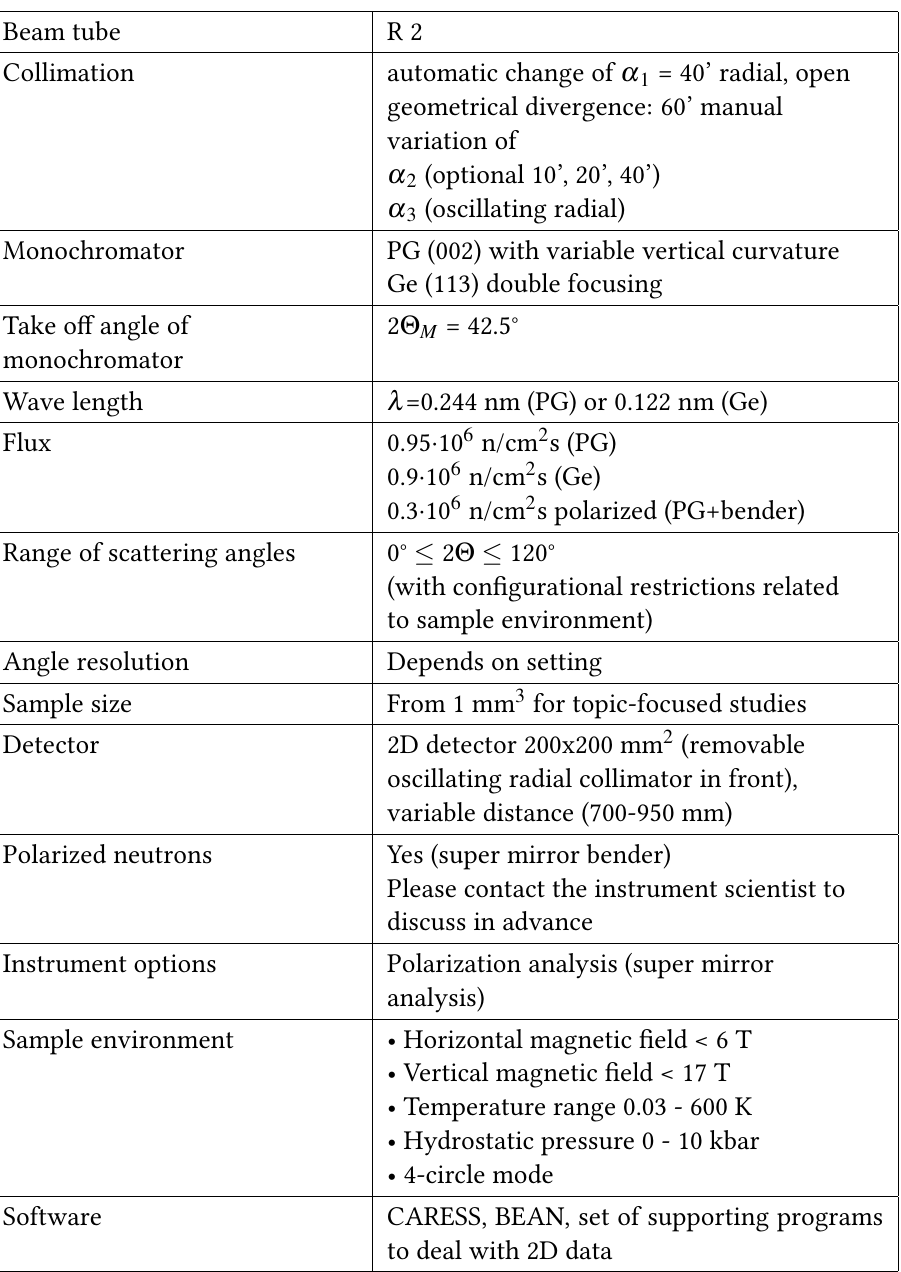
Table 1: Technical parameters of